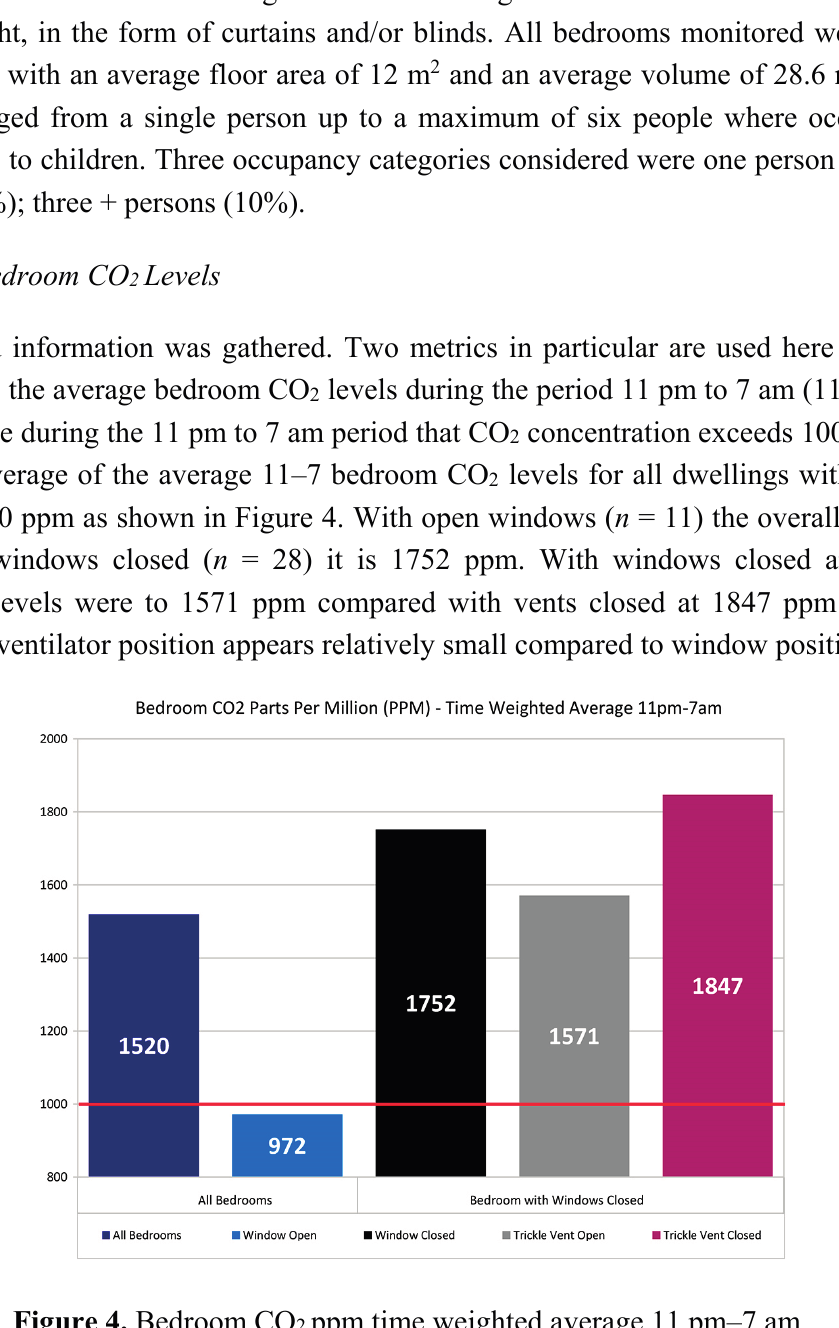
Figure 4. Bedroom CO 2 ppm time weighted average 11 pm–7